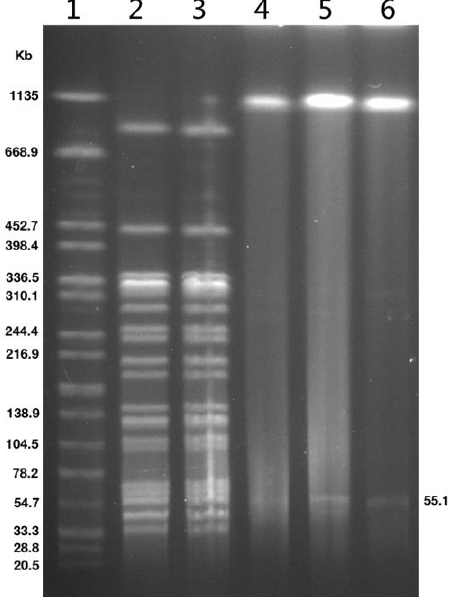
Figure 2. PFGE of Pseudocitrobacter faecalis clinical isolates and transformant. * Lanes 1, marker Salmonella braenderup H9812; line 2 to 3, PFGE image of P. faecalis SC48, SC62; line 4 to 6, S1-PFGE image of P. faecalis SC48, SC62 and E. coli DH5α -SC48-T. Table 1. Minimal inhibitory concentrations (MICs) of Pseudocitrobacter faecalis clinical isolate, transformant, and recipient.